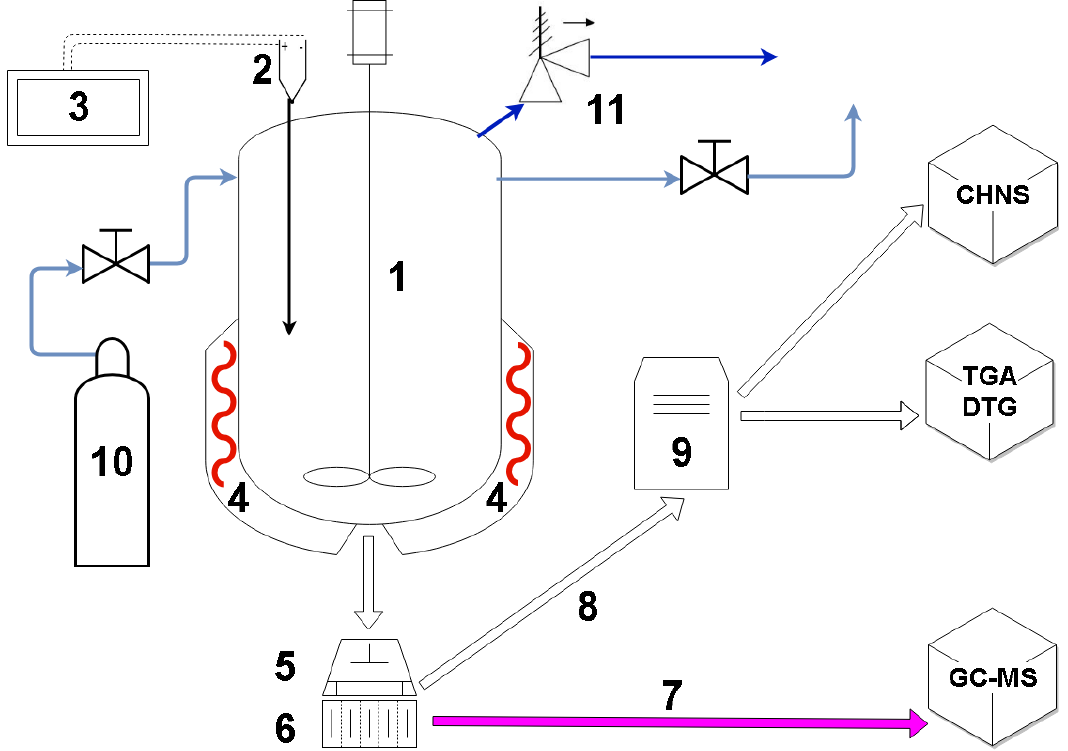
Figure 1. Diagram of the test rig used for hydrothermal carbonization (HTC) of the spent grain. ( 1 ) — Autoclave; ( 2 ) — type K thermocouple; ( 3 ) — PLC controller; ( 4 ) — heating mantle, with band heaters; ( 5 ) — hydraulic press; ( 6 ) — filter; ( 7 ) — liquid after mechanical de-watering; ( 8 ) — hydrochar after mechanical de-watering; ( 9 ) — dryer; ( 10 ) — nitrogen for purging; ( 11 ) — pressure relief valve.